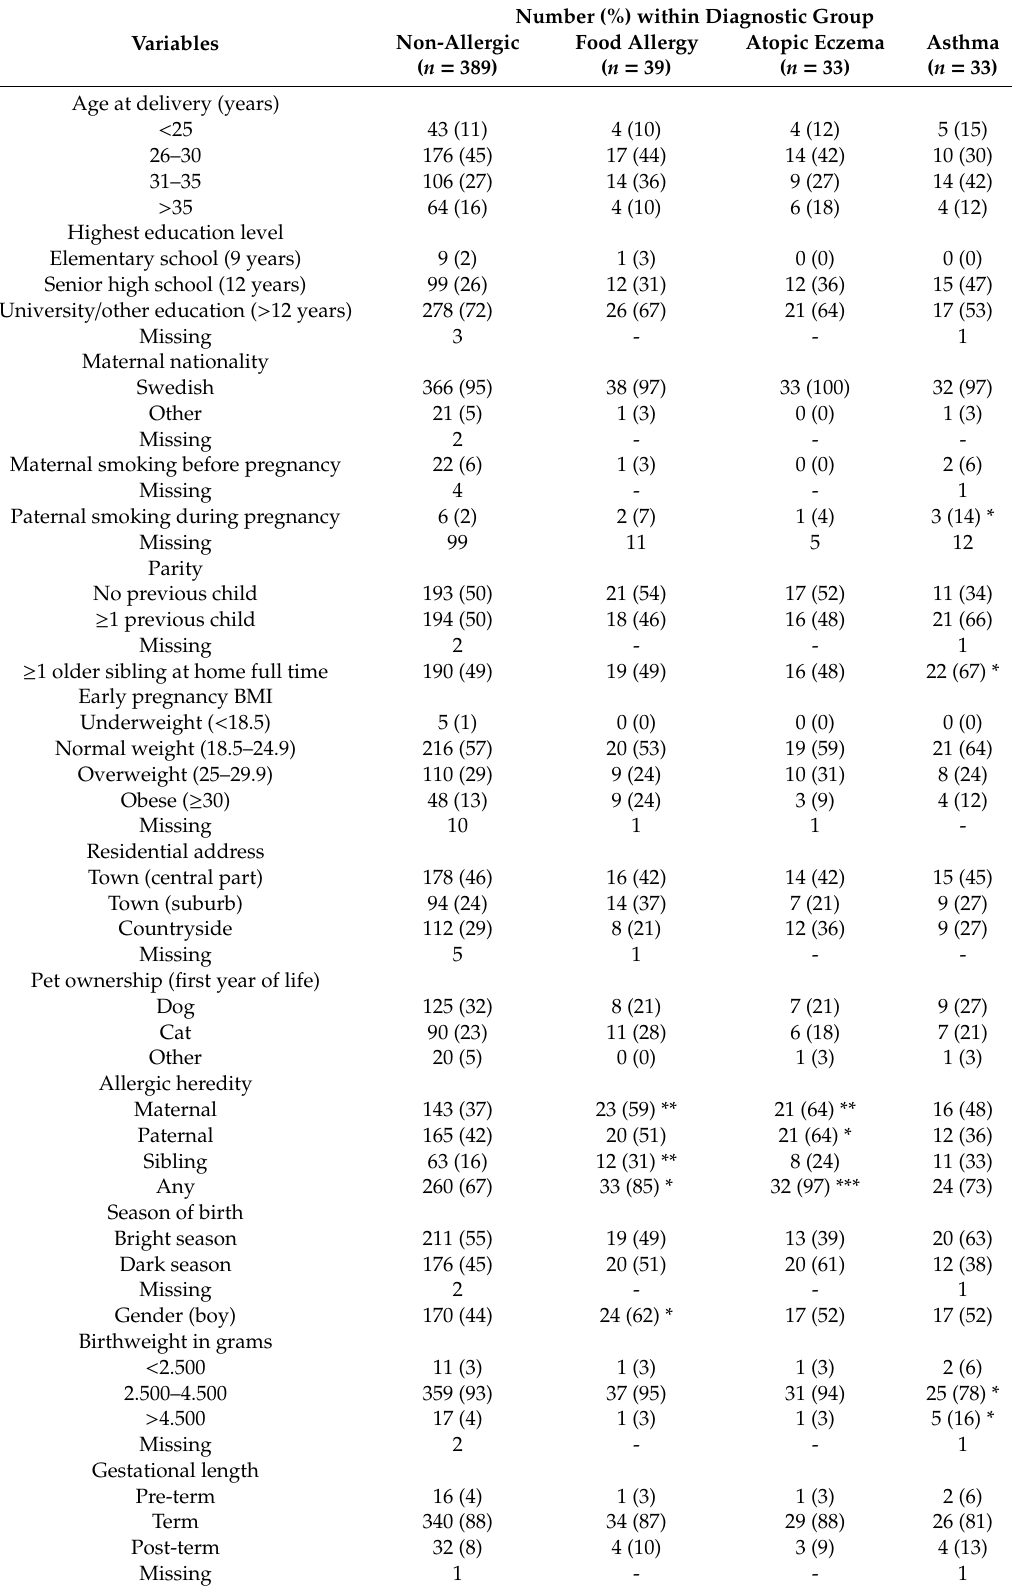
Table 1. Characteristics of children with food allergy, atopic eczema, and asthma, as compared to non-allergic children (i.e., non-allergic, non-sensitized, and non-asthmatic) ( n =